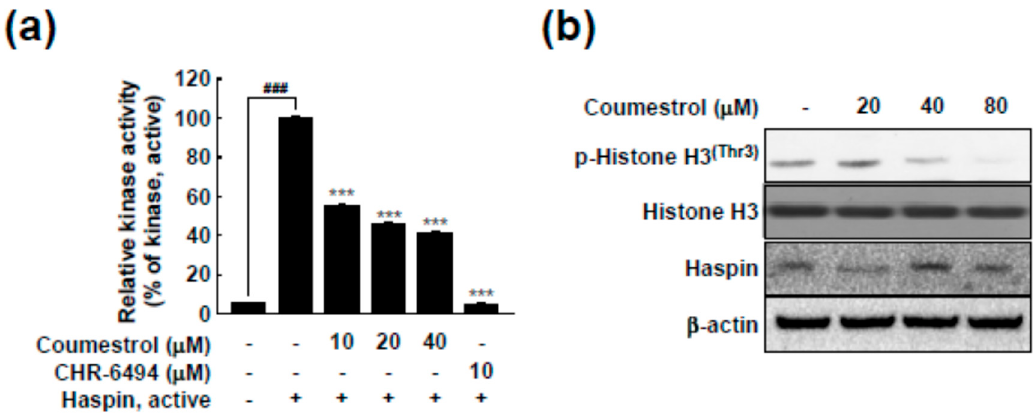
Figure 4. Coumestrol directly suppresses haspin kinase activity and the phosphorylation of histone H3 at Thr-3. ( a ) The effect of coumestrol on haspin kinase activity was investigated using recombinant haspin kinase. CHR-6494, a haspin kinase inhibitor, was used as a positive control; and ( b ) The effect of coumestrol on the haspin downstream signaling pathway was confirmed. Protein levels were detected with specific primary antibodies. Data are representative of three independent experiments, which gave similar results. The pound ( ### ) signs indicate a significant difference at p < 0.001, compared to the untreated control and the asterisks (***) indicate a significant difference at p < 0.001 compared to the kinase treated group.